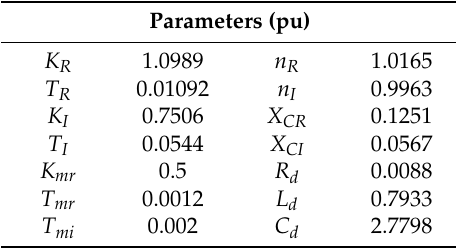
Table A1. HVDC transmission